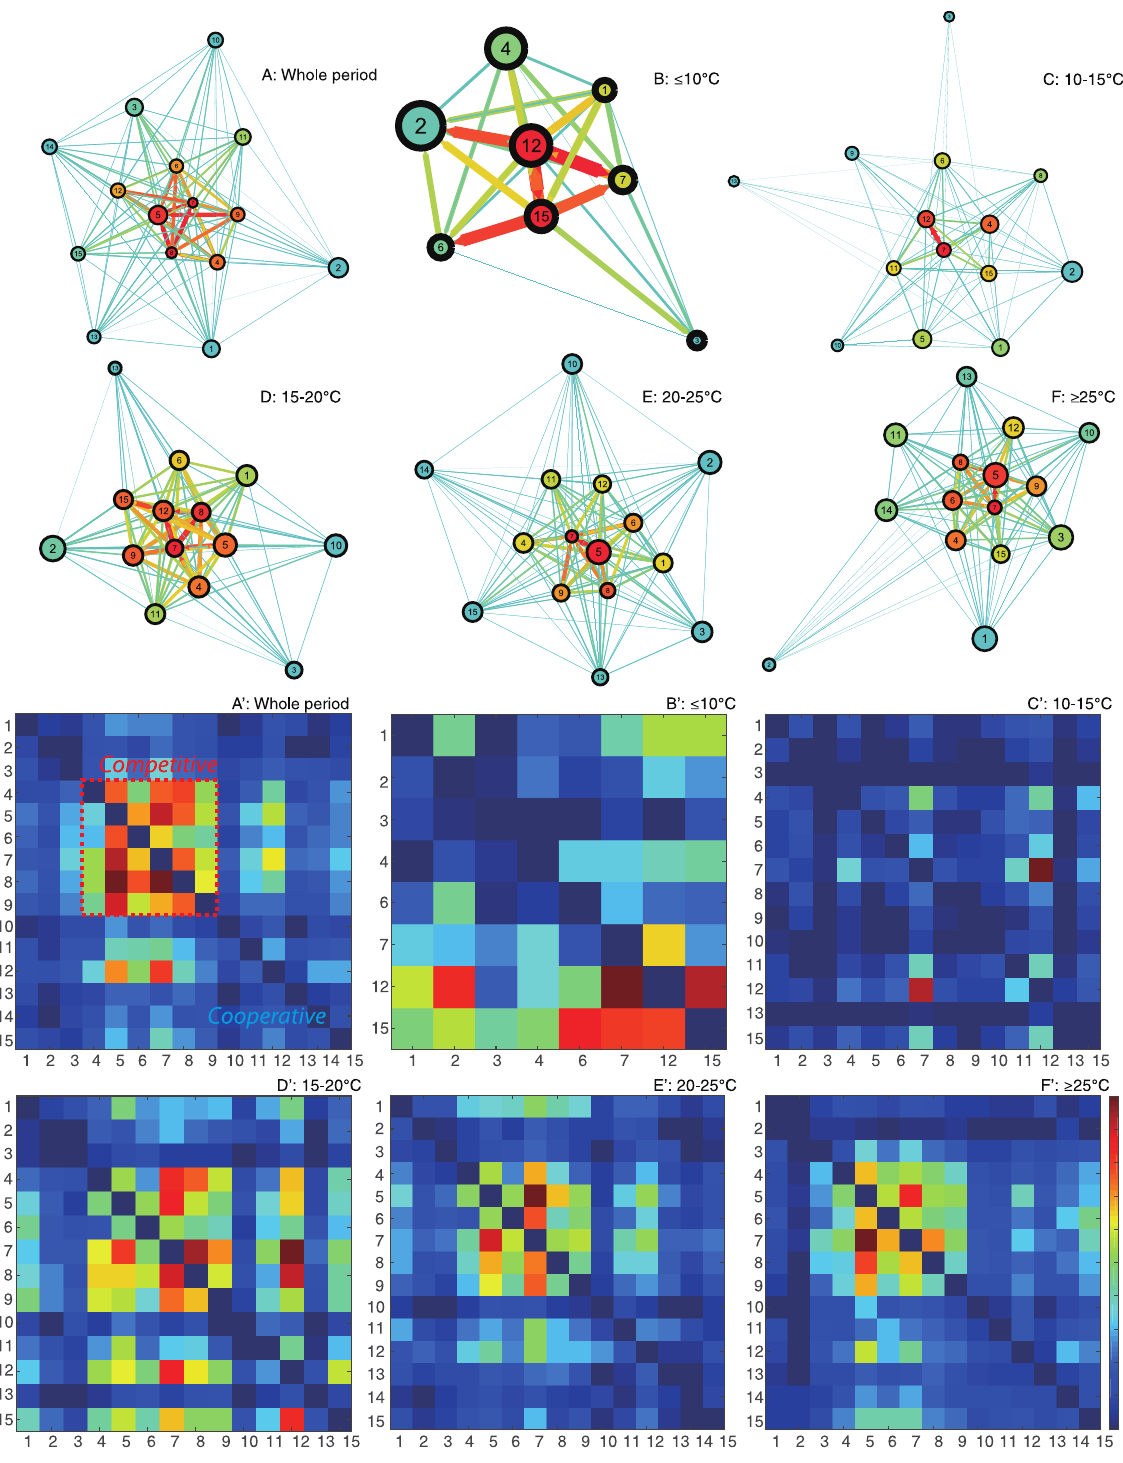
Fig 4. OIF-inferred species interaction networks and matrices. The OIF model is used to infer the causal interactions between all pairs of species, yielding average interaction (TE) matrices for the whole time period and five TRs. TE values in interaction matrices are normalized to 1 and drawn in plots A’, B’, C’, D’, E’ and F’. After removing weak interactions by setting a threshold (TE = 0.01) to filter TEs, species interaction networks are reconstructed using Gephi (https://gephi.org/) and shown in plots A, B, C, D, E and F. The size and color of nodes is proportional to the Shannon Entropy of species abundance and the total outgoing transfer entropy (OTE) (the greater OTE, the warmer the color); the width and